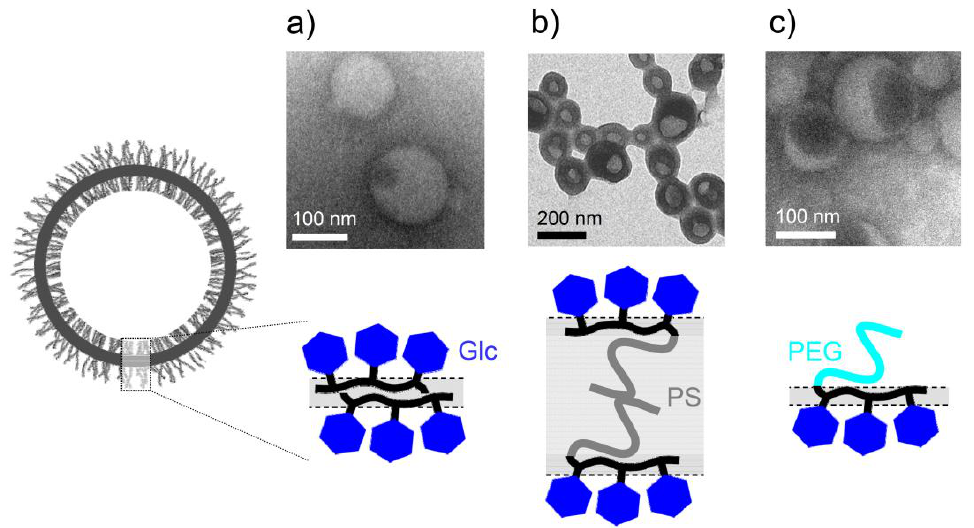
Figure 10. Transmission electron micrographs and schematic illustrations of the membrane morphology of vesicles formed by ( a ) glucosylated PBD, ( b ) glucosylated PBD- b -PS, and ( c ) glucosylated PBD- b -PEG in dilute aqueous